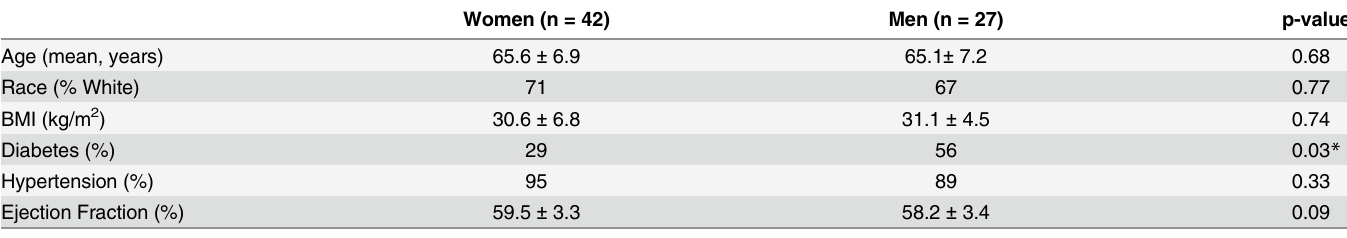
Table 1. Comparison of characteristics between women and